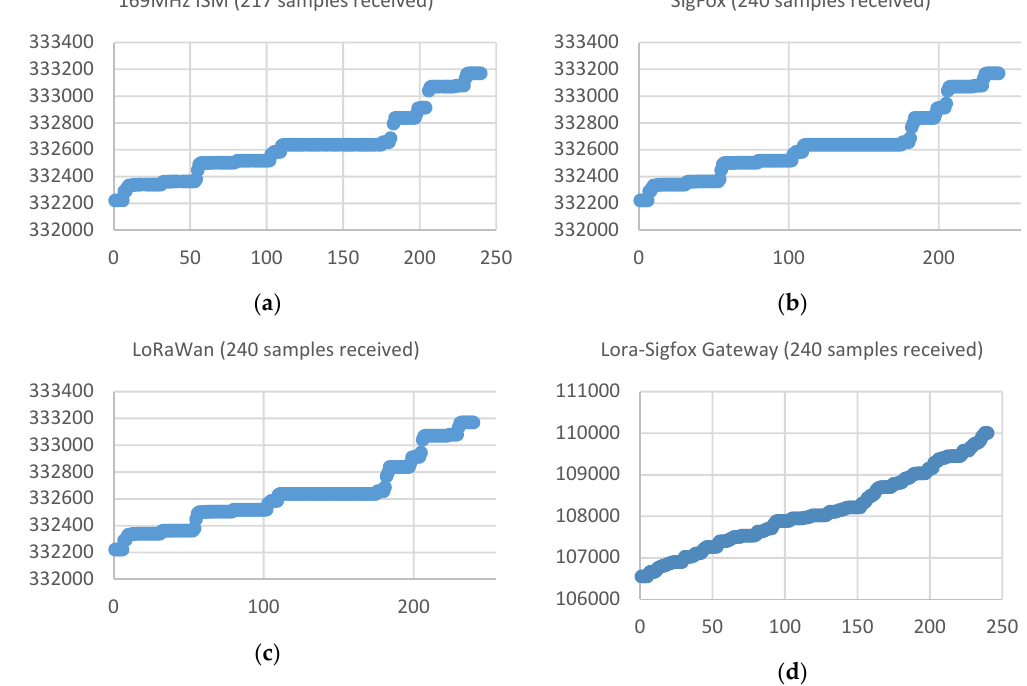
Figure 24. Number of samples received in the case of a building in which a reception rate higher than 75%. ( a ) In the 169 MHz ISM band, 217 samples were received (90.4%). ( b ) Reception rate with the Sigfox prototype of 100%. ( c ) Reception rate with the LoRaWan device of 100%. ( d ) Reception rate with the LoRa-Sigfox Gateway device of 100%.